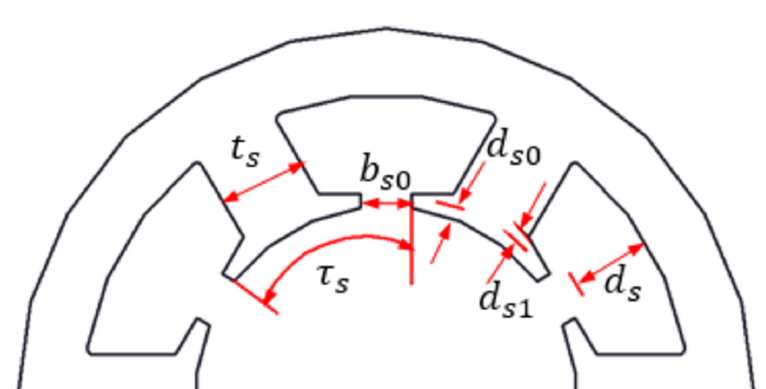
Figure 4. Stator slot